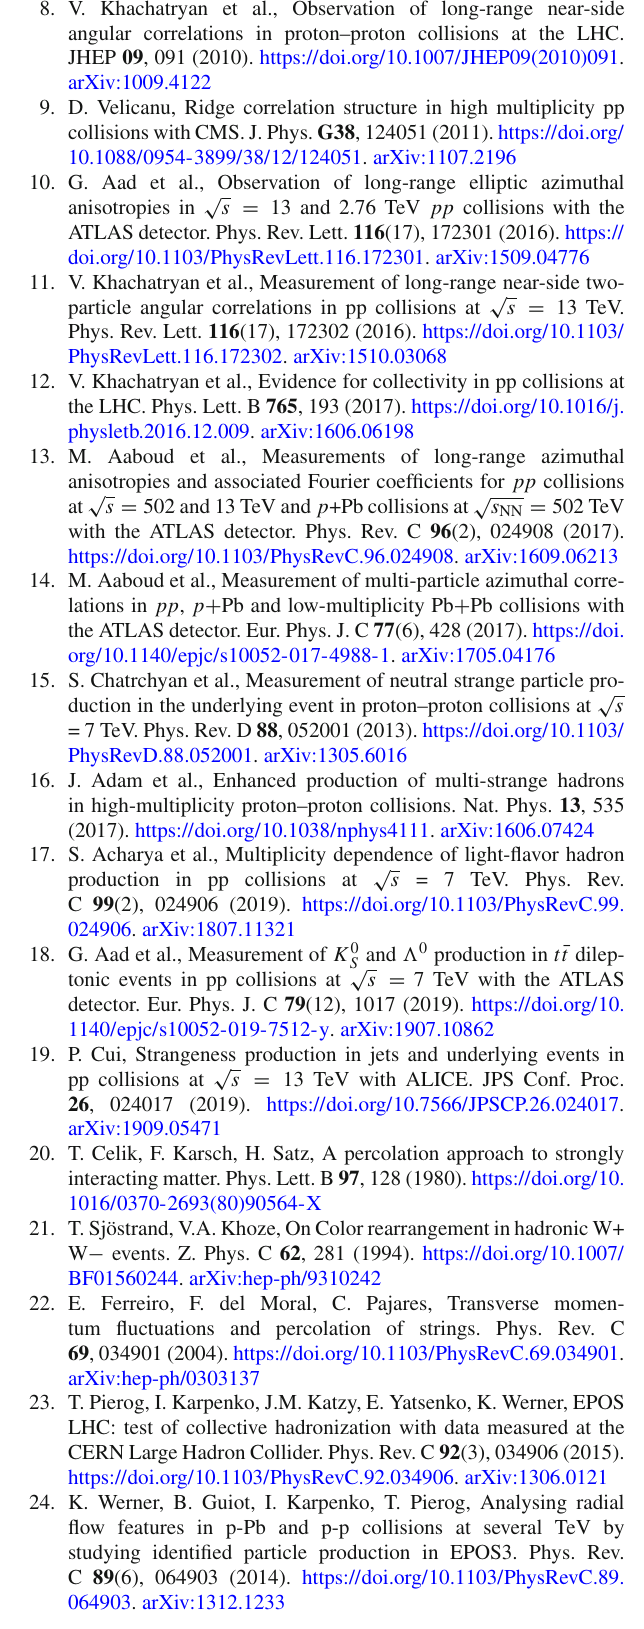
for several values of τ 0 subject to (cid:4) κ(τ) (cid:6) = κ